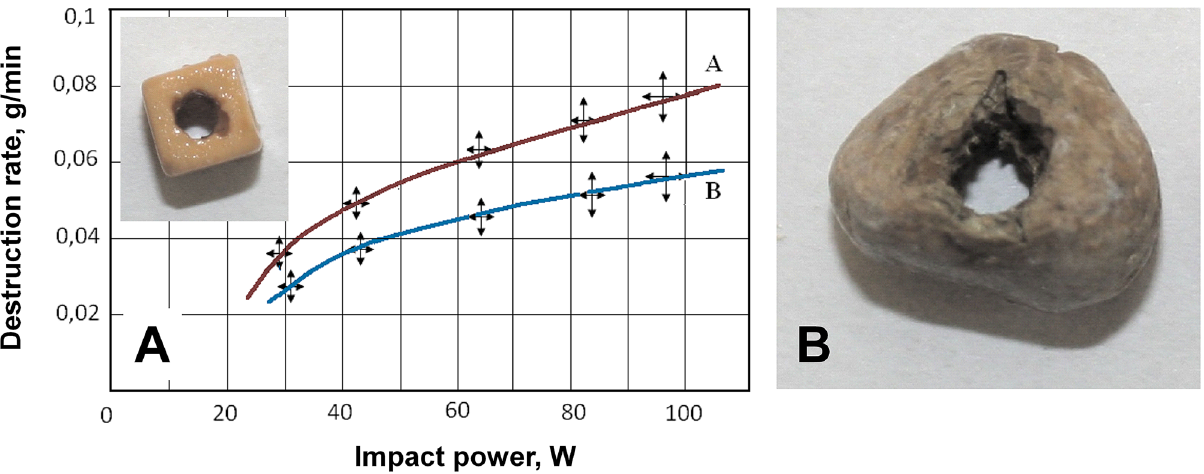
Figure 4. Dependence of the destruction rate ( A ) of oxalate (red) and phosphate (blue) dummy kidney stones on the average impact power. The phase of destruction of the real kidney stone is shown ( B